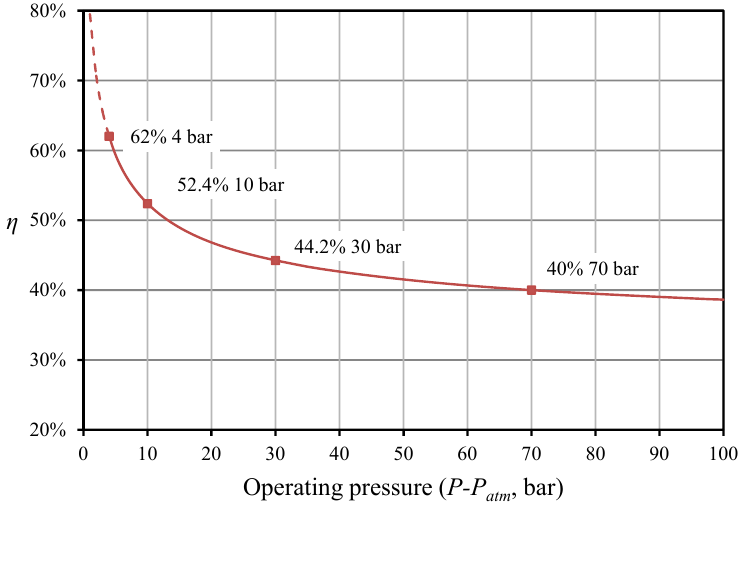
Figure 6. The converting efficiency under constant pressure